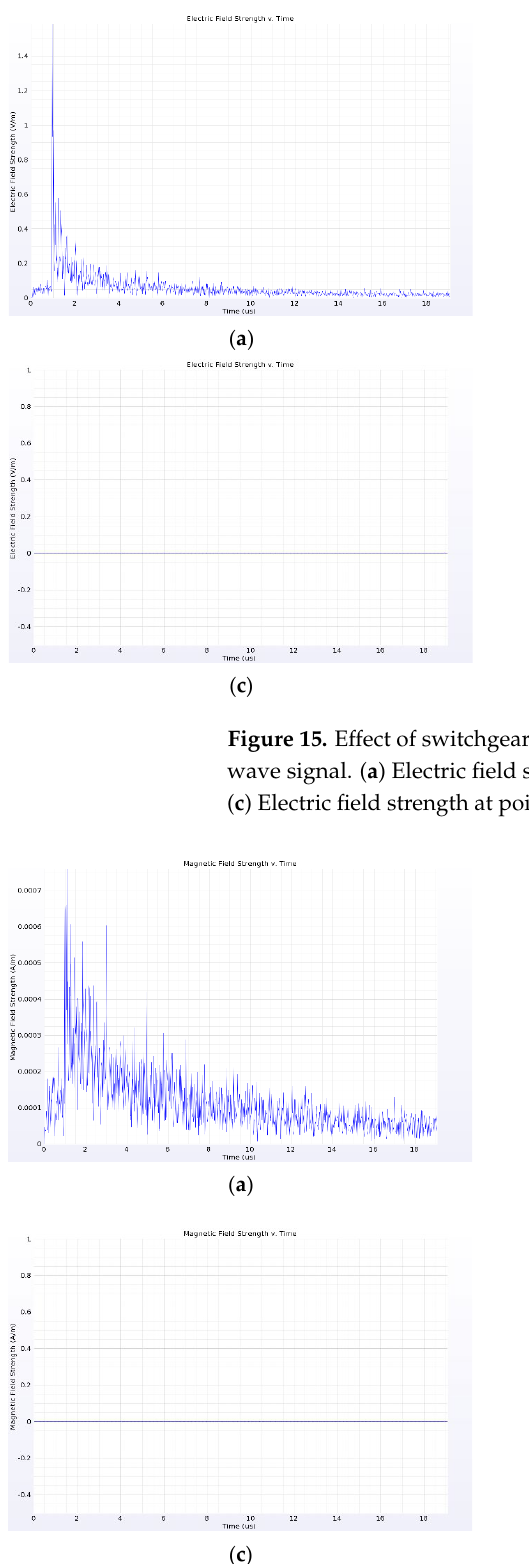
Figure 14. Location distribution of source and point sensors around switchgear wall .